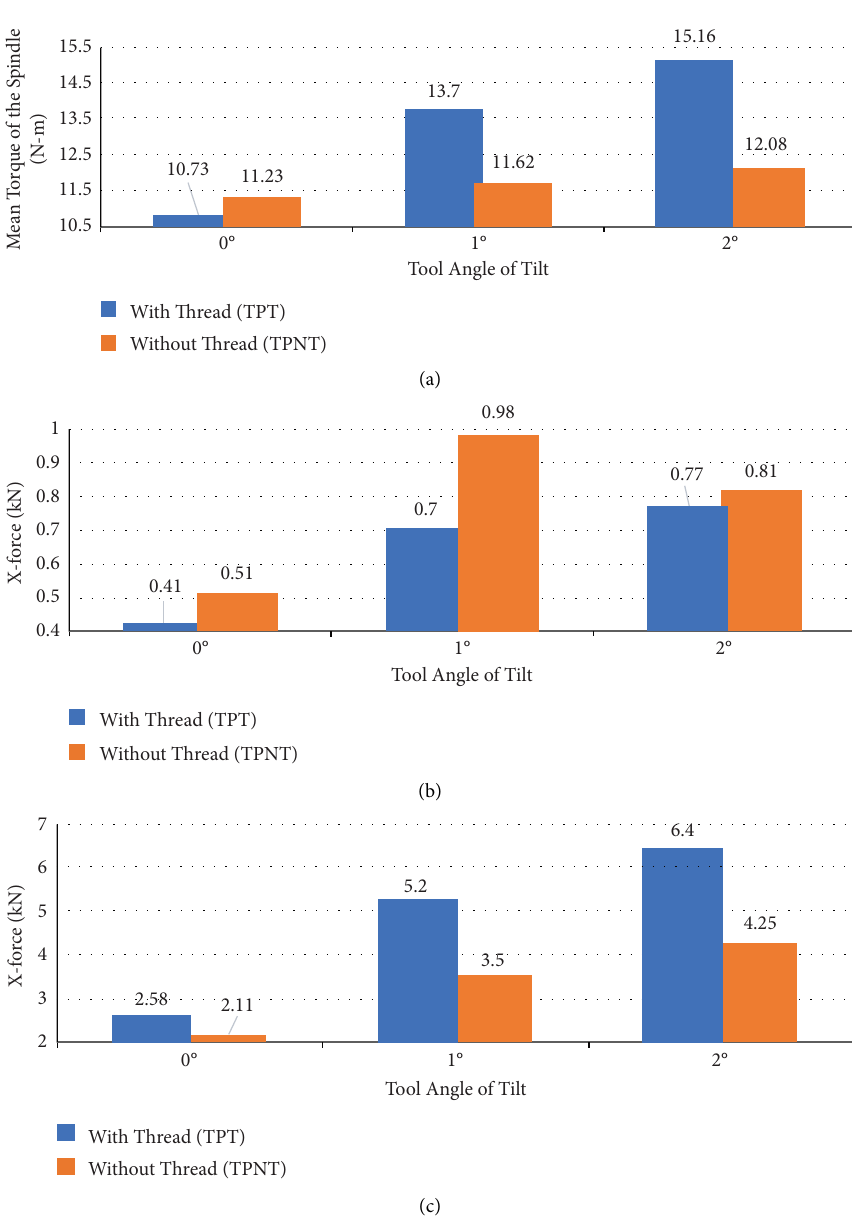
Figure 3: (a) Torque induced in the spindle, (b) longitudinal force ( X -force) in tool pin, and (c) ( Y -force) acting vertically downwards in reference to the angle of tool